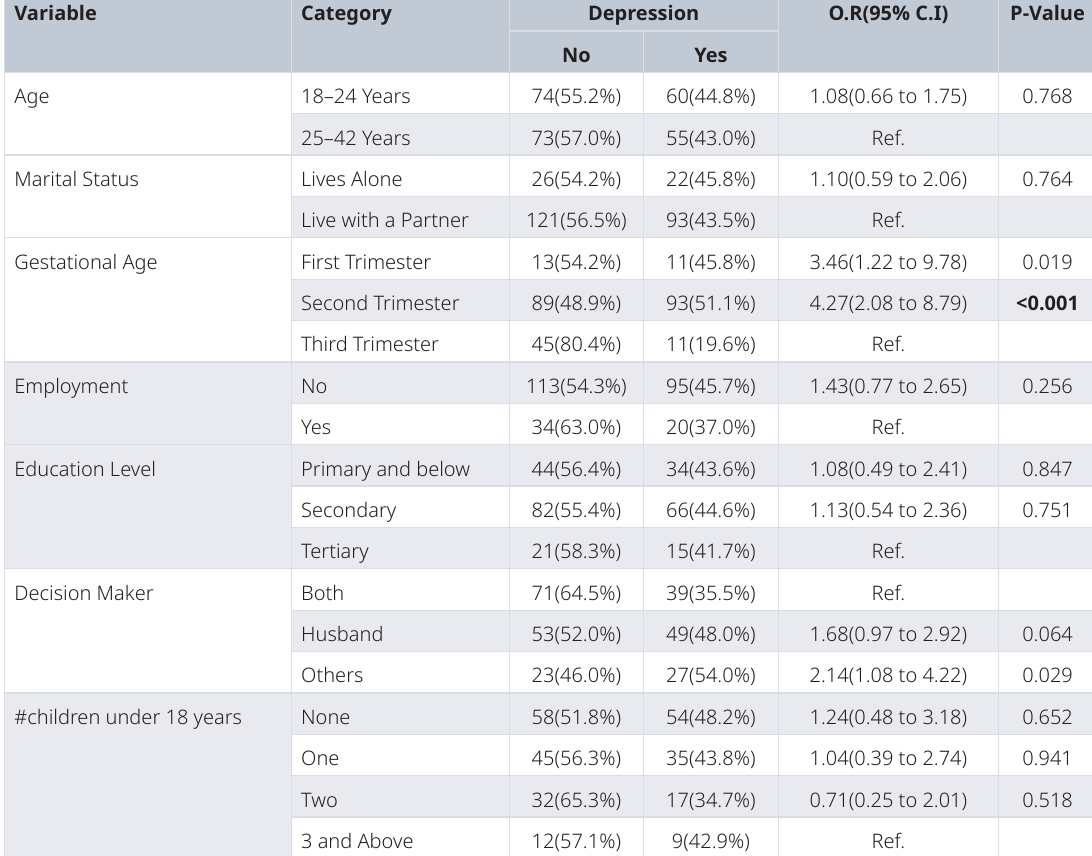
Table 2. Sociodemographic characteristics associated with prepartum depression in urban low-income settlements Nairobi, Kenya. (EPDS score of ≥ 13.